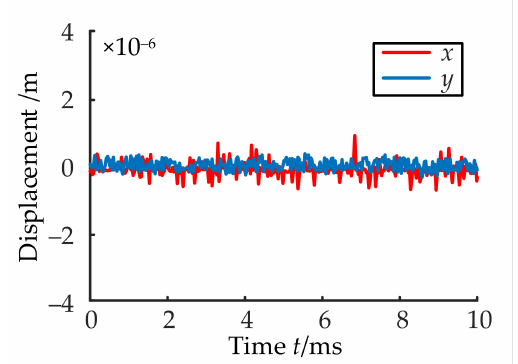
Figure 18. Steady-state displacement under single suspension.